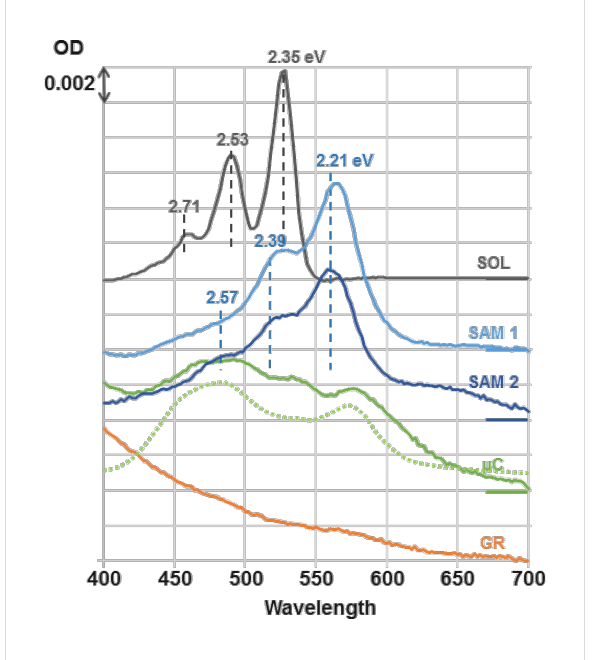
Figure 3: Normal incidence transmission spectra T , expressed as an optical density DO = − log( T / T 0 ). SOL: a 10 − 6 M solution of PTCDI in toluene, cell thickness: 2 mm (black curve). SAM1 and SAM2: two self- organized PTCDI-C13 monolayers on graphite, formed following two methods: drop casting (light blue, SAM1) or dip coating (dark blue, SAM2). µC: 10 equivalent monolayers of PTCDI-C13 deposited by sol- vent evaporation on a fused-quartz substrate, that is without CVD graphene (green curve) and PTCDI-C13 microcrystalline thin film (dotted green curve) reproduced after Mizuguchi et al. [36] and rescaled for easier comparison. GR: monolayer CVD graphene trans- ferred onto a fused-quartz plate (orange curve). All spectra are refer- enced ( T 0 ) to their corresponding naked substrate (GR for SAM1 and SAM2, quartz plate for µC and GR) or pure solvent (SOL). The ener- gies of the 0–0, 0–1 and 0–2 vibronic peaks are indicated for solution and monolayer